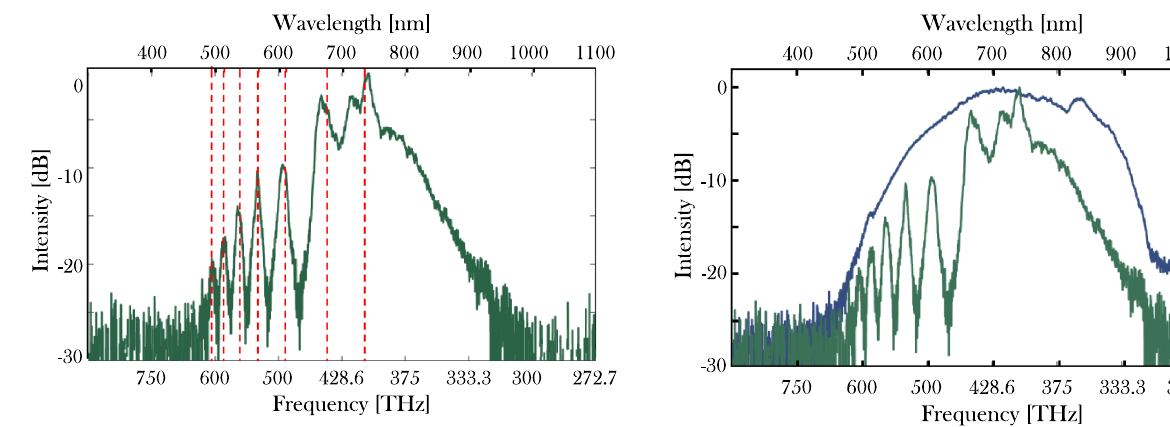
Fig. 4 A comparison between experimentally observed dispersive spectrum in a graded-index and a step-index multimode fi ber. A comparison between dispersive waves (DWs) generated in a step-index multimode fi ber (MMF) (blue curve) and a parabolic-index MMF (green curve). The step-index MMF had a length of 10 m, a core diameter of 105 µ m and a numerical aperture NA = 0.22. In both cases the extent of the DW spectrum is approximately the same. However, the DWs generated from a step-index MMF do not have the comb-like features, a signature of parabolic